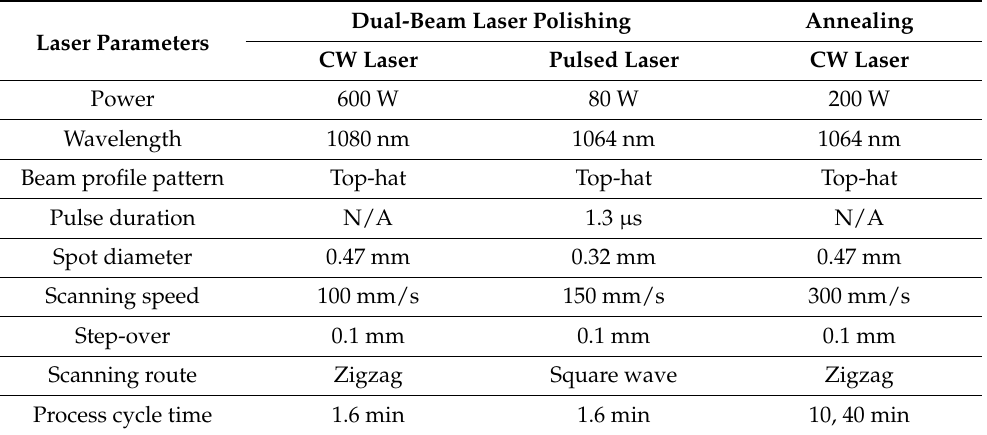
Table 1. Parameters of the dual-beam laser polishing and CW laser annealing. Dual-Beam Laser Polishing Annealing Laser Parameters CW Laser Pulsed Laser CW Laser Power 600 W 80 W 200 W Wavelength 1080 nm 1064 nm 1064 nm Beam profile pattern Top-hat Top-hat